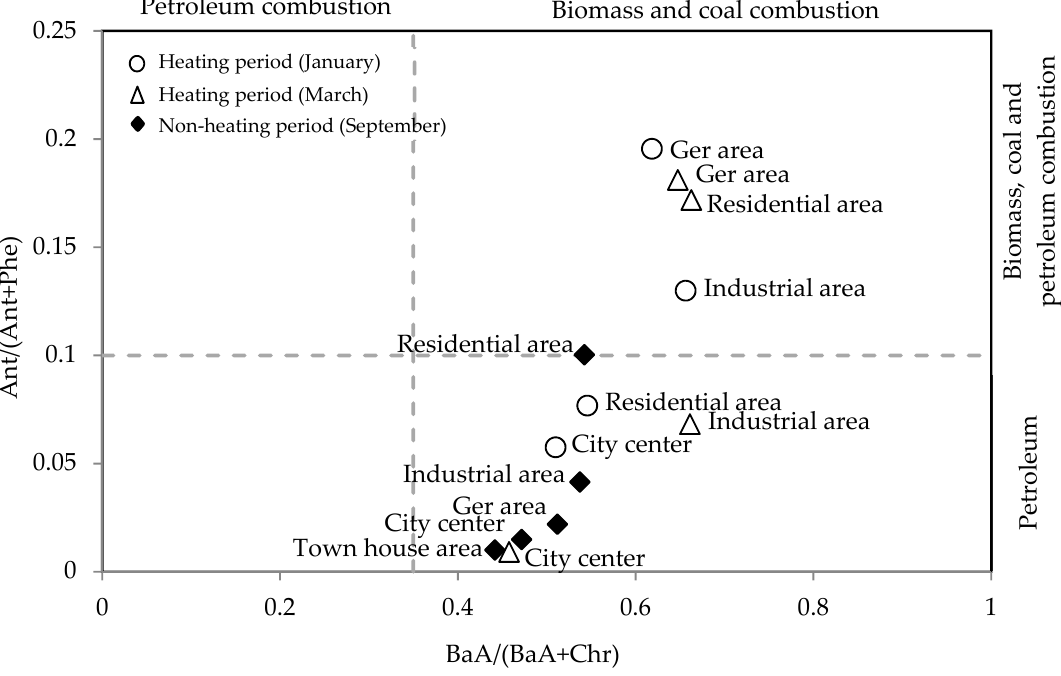
Figure 6. Cross plot of the diagnostic ratios for the sources of PAHs in winter and late summer.